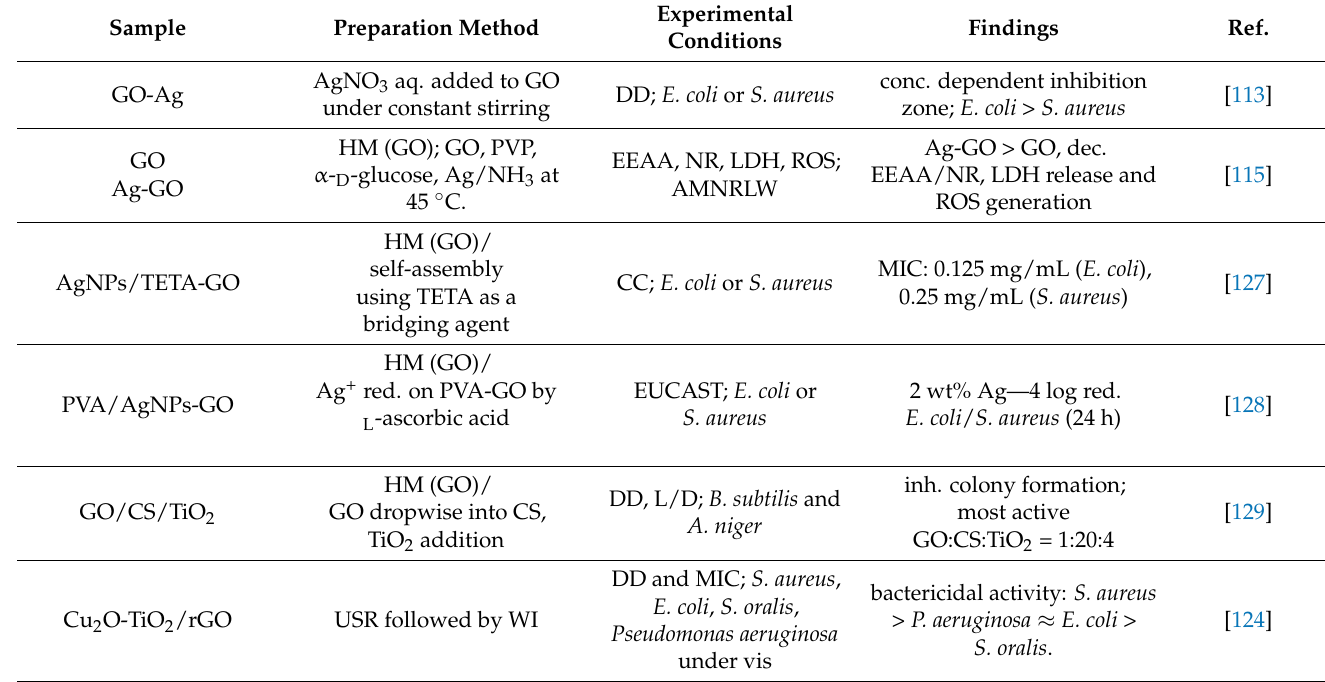
Table 3. Graphene-based composites with metals and metal oxides for microbial disinfection. Sample Preparation Method